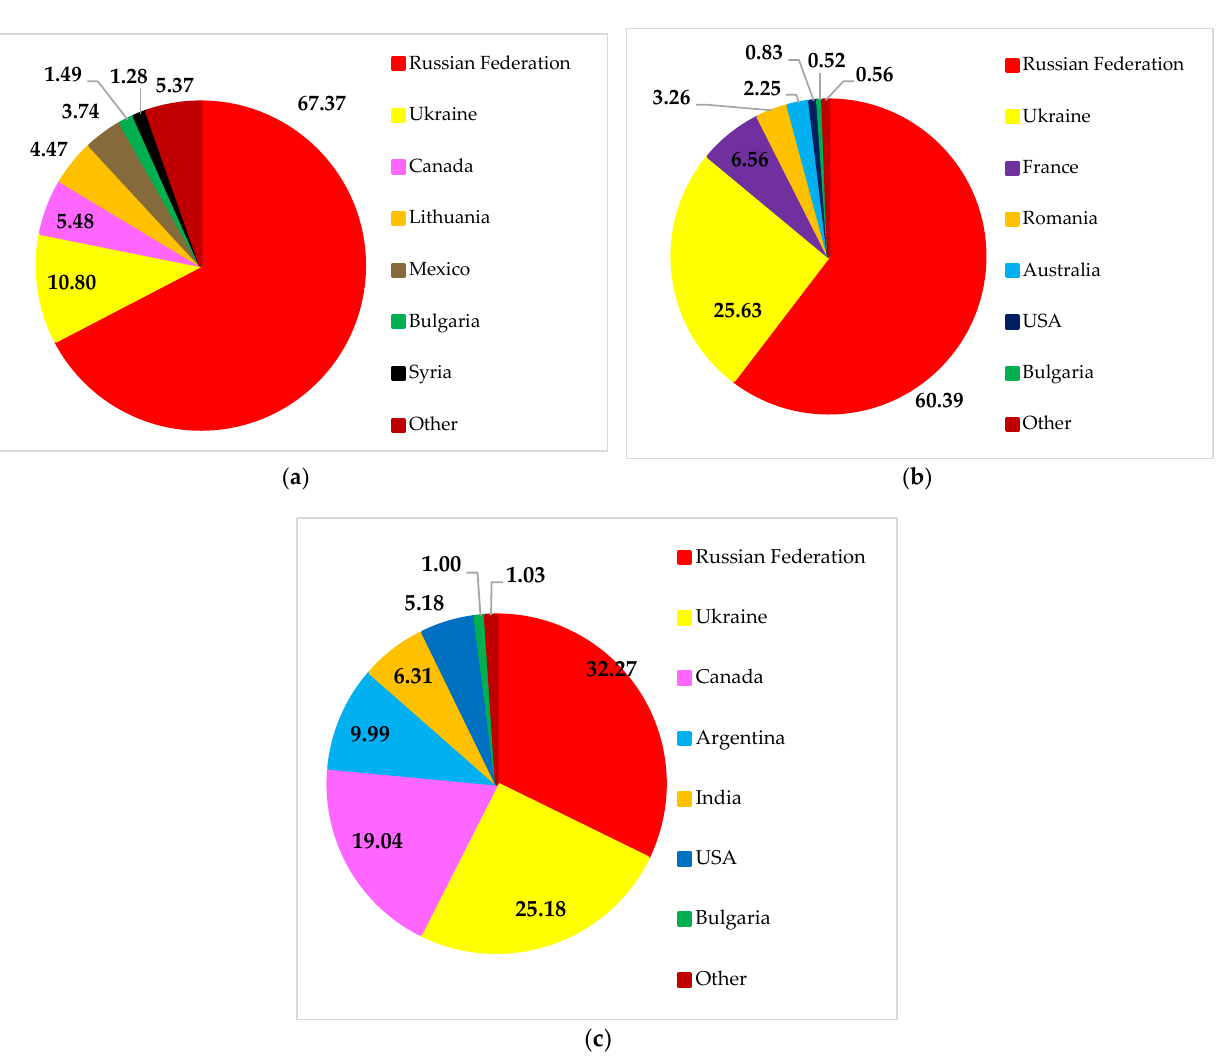
Our next effort was to consider the role of Russia and Ukraine as soybean exporters. Russia and Ukraine are exporters of soybeans to the world market, although in small quantities (Figure 9). Both countries’ export trends indicated a slight rise by a certain amount. The peak of Ukrainian soybean exports occurred in October, while Russian soy- bean exports fluctuated dramatically.